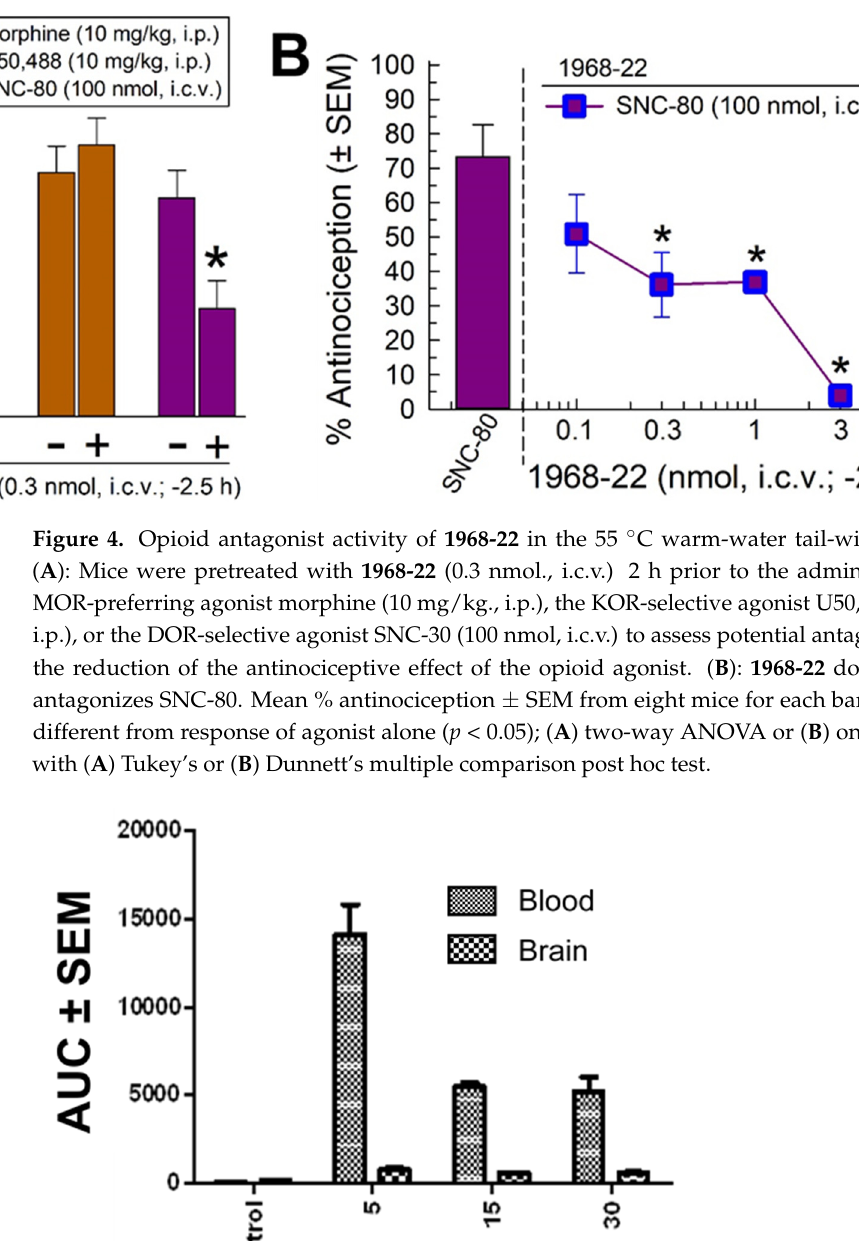
Figure 5. LC-MS/MS analysis of 1968-22 (10 nmol, i.v.) in blood and brain samples isolated from treated mice over 30 min. Control mice received vehicle (10% Ethanol/10%Tween-80/80% 0.9% saline) and were harvested immediately. Points are mean AUC ± SEM for the summed ion extracted chromatographs of 1968-22 from three mice/time